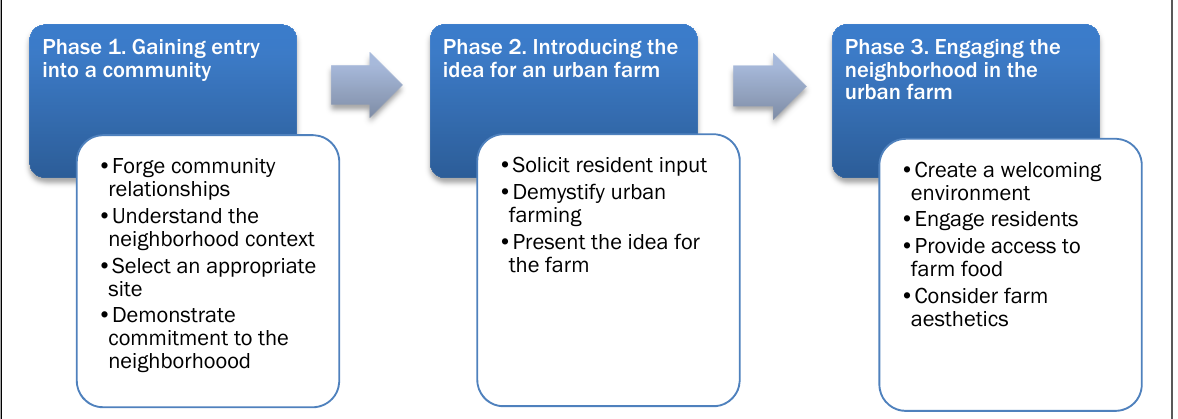
Figure 1. Strategies Used by Urban Farmers in Baltimore City to Gain Community Buy-in